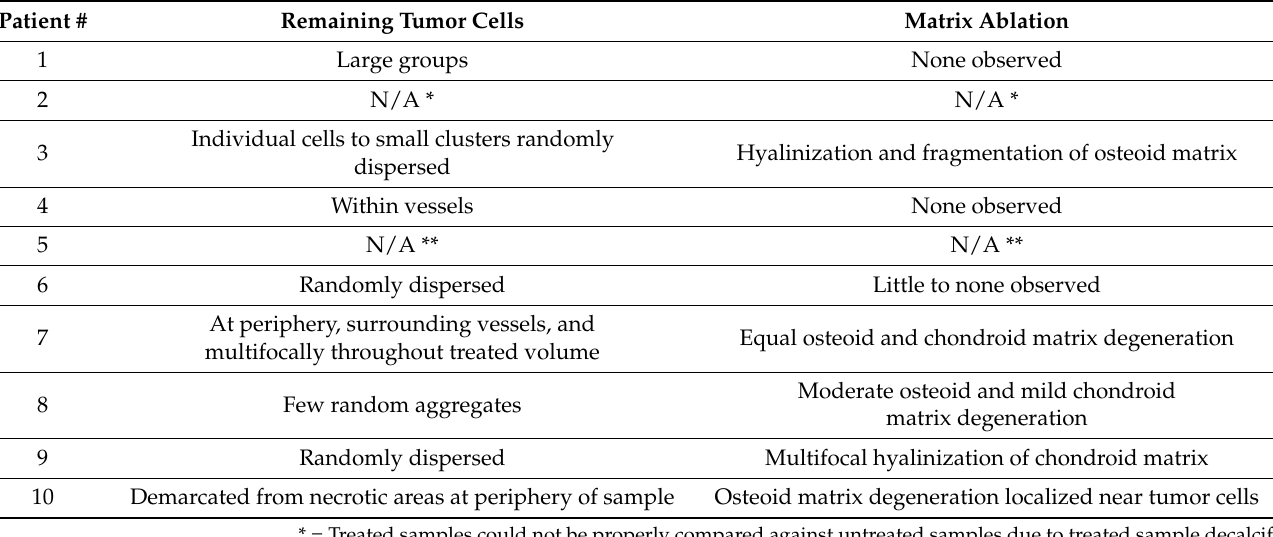
Table A1. Additional histologic tumor observations following histotripsy